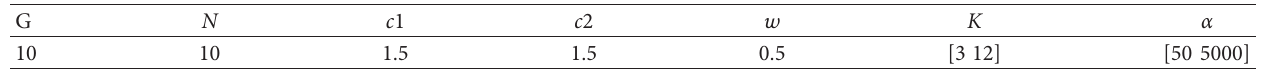
Figure 7: Time domain waveforms of original vibration signals. (a) Normal working state. (b) Single plunger loose slipper. (c) Double plungers loose slipper. (d) Piston shoe wear. Table 1: Parameters of